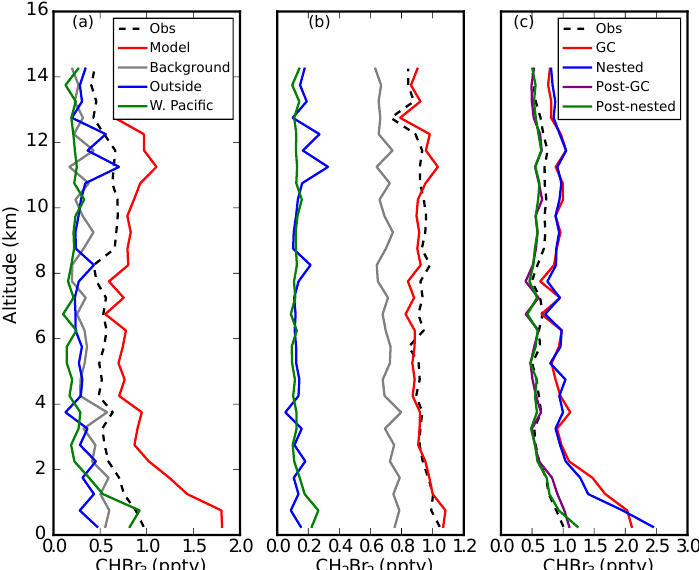
Figure 2. Observed and model mean vertical profiles of (a) CHBr 3 (pptv) and (b) CH 2 Br 2 (pptv) from the CAST and CONTRAST cam- paigns, described on a 1km resolution grid. Model values have been sampled at the time and location of each observation. Also shown are the model contributions to these gases from within the western Pacific study region, immediately outside the study region and further afield, which we denote as background values. Panel (c) compares CAST and CONTRAST observations of CHBr 3 with GEOS-Chem model simulations using the standard (2 . 0 ◦ × 2 . 5 ◦ ) and nested (0 . 25 ◦ × 0 . 3125 ◦ ) spatial resolutions from 18 January to 13 February 2014. The two model runs (red and blue lines) use the same emission inventories (Ordóñez et al., 2012). For comparison, we also present posterior model simulations (purple and green lines) based on the a posteriori fluxes inferred from CAST and CONTRAST observations (Fig.